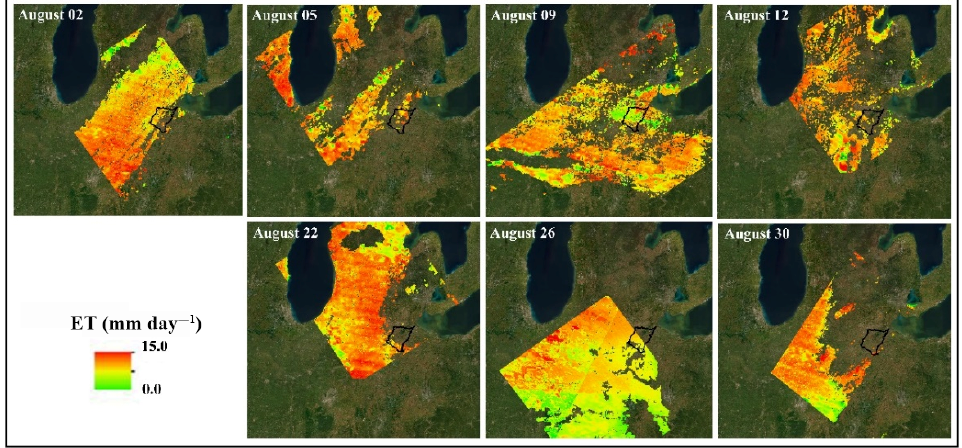
Figure 3. Available ECOSTRESS daily ET (mm day − 1 ) data acquired over the study area during the 2018 growing season. The black polygon denotes the extent of the study area.